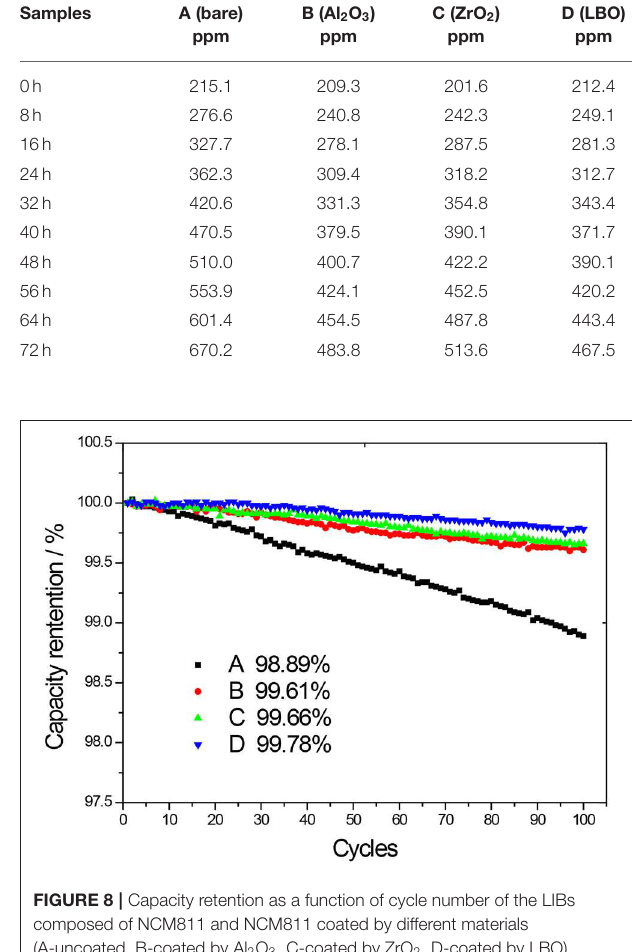
TABLE 3 | Water values of NCM811 and the NCM coated with Al 2 O 3 , ZrO 2 and LBO, stored at 25 ◦ C in 10% RH humidity environment. Samples